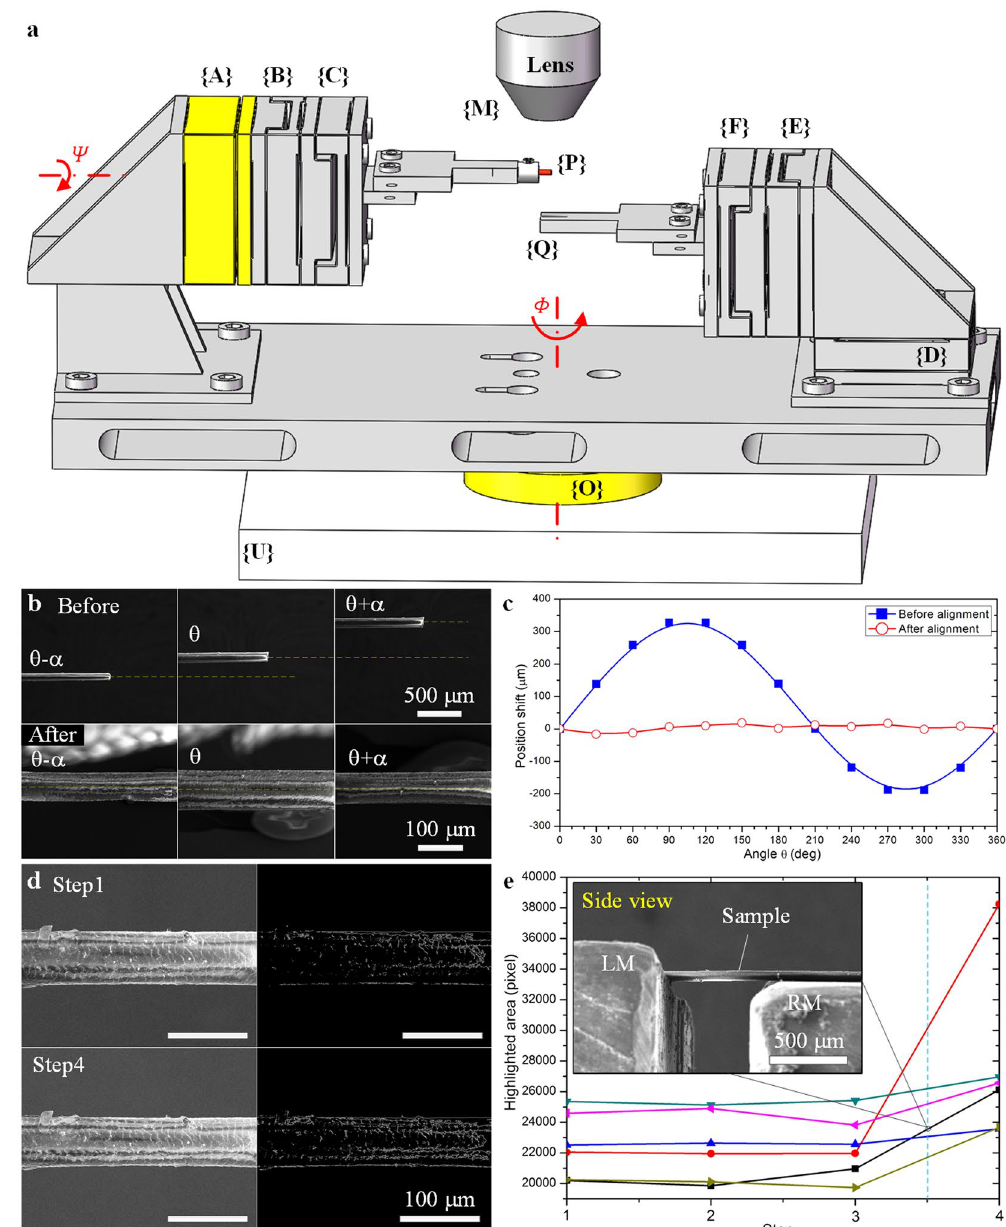
Figure 2. Sample alignment on LM and RM. ( a ) Illustration of the initial assembly errors. Φ and Ψ are the initial rotational errors on the two rotational joints of the robot. ( b ) Sample’s position before and after LM alignment by TIA approach. α is chosen as 90°. ( c ) Offset Δ P err in one revolution (360°) before and after LM alignment. ( d ) SEM image and highlight area (unit: pixel) of the sample at initial condition and after deformation, corresponding to the black line in ( e ). ( e ) Changing of the highlighted area during the upward movement of RM. Six experiments are designed independently by taking six different samples. The side view image is taken at step 3.5 corresponding to the sample indicating by black